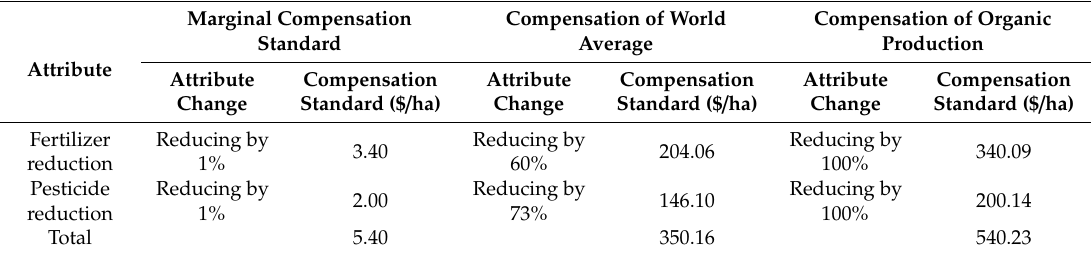
Table 5. Compensation for di ff erent attributes and control